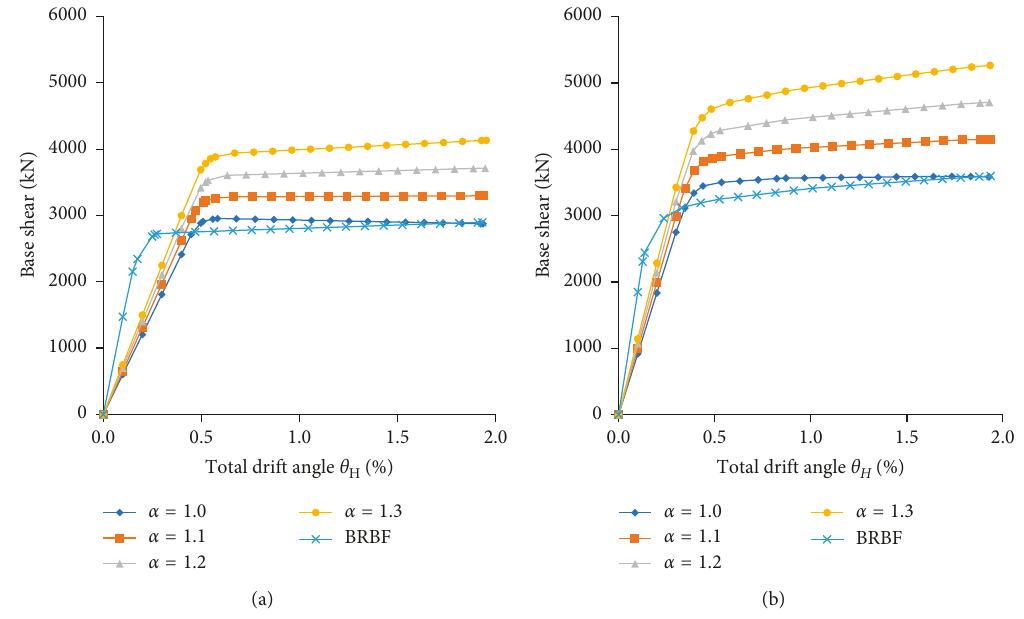
Figure 20: The effects of α on the base shear response of 9-story SC-TOBFs: (a) LD-1 and (b)